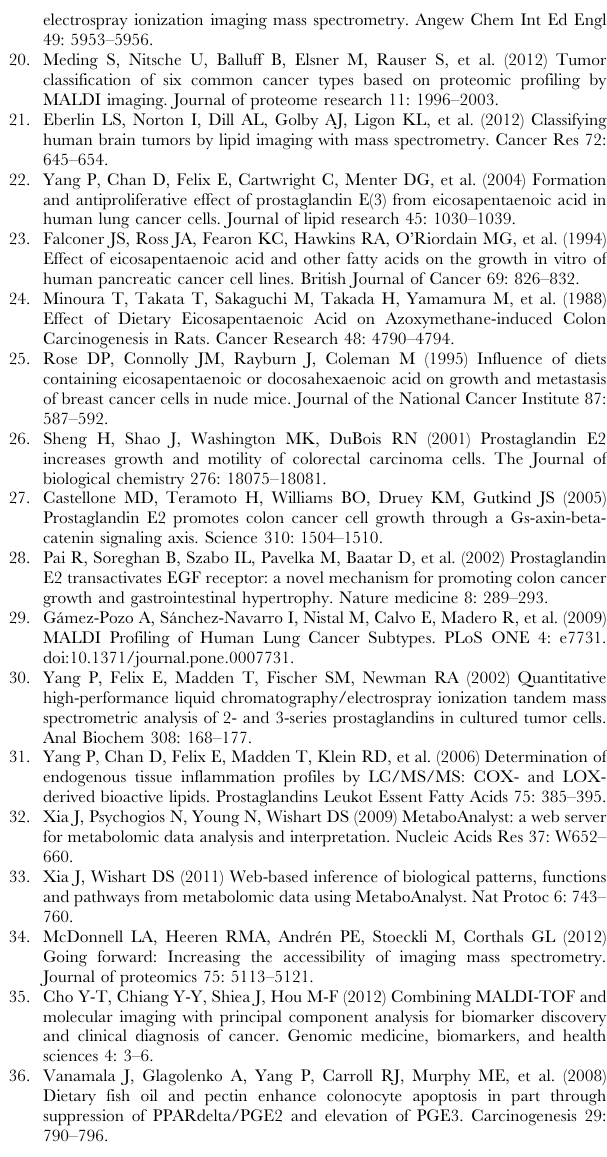
Figure S1 Mass spectra collected directly from each cell line, untreated A549 (A) and H596 (B) versus 50 m M EPA-treated A549 (C) and H596 (D). Consistent with the PCA data analysis,